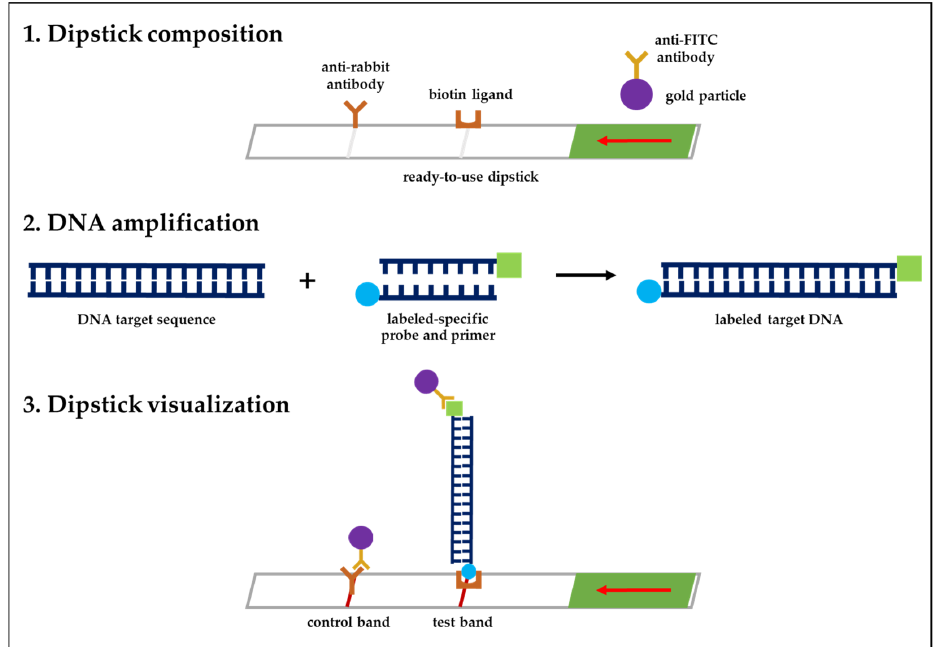
Figure 4. The lateral flow mechanism of the HybriDetect dipstick. ( 1 ) The sample application area of the dipstick is composed of gold ‐ labeled FITC ‐ specific antibodies. ( 2 ) Amplification of DNA by RAA nfo is performed using analyte detectors labeled with FITC (probe) and biotin (primer) that attach to the DNA target sequence. ( 3 ) The labeled analytes bind to the gold ‐ labeled FITC ‐ specific antibodies, travel to the membrane, and bind to immobilized biotin ‐ ligand molecules while passing the test line, eventually generating a red ‐ blue band. Unbound gold particles then migrate to the control line.